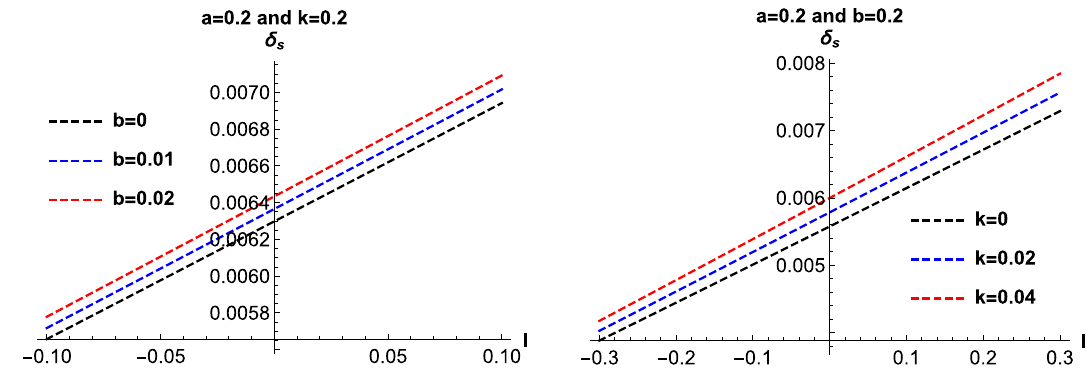
Fig. 15 The figure at the left side represents the variation of deviation from circularity δ s with l for different values of b with a = 0 . 2 and k = 0 . 2. The figure at the right side represents the variation of δ s with l for different values of l with a = 0 . 2 and b = 0 .